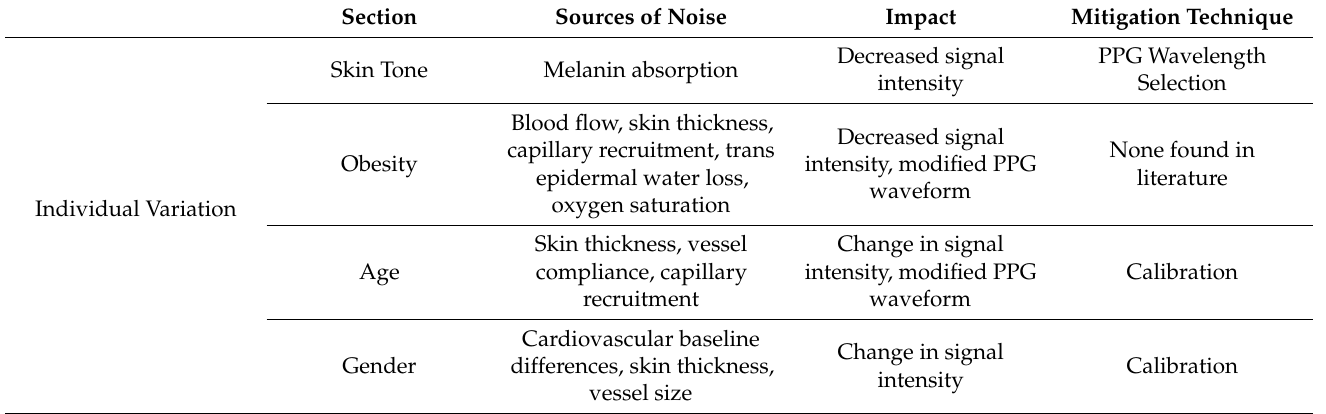
Table 7. Summarized noise sources, effect, and